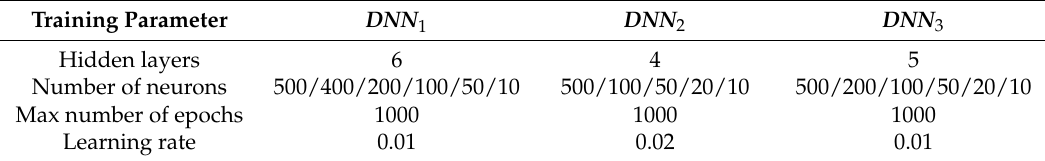
Table 2. DNN model